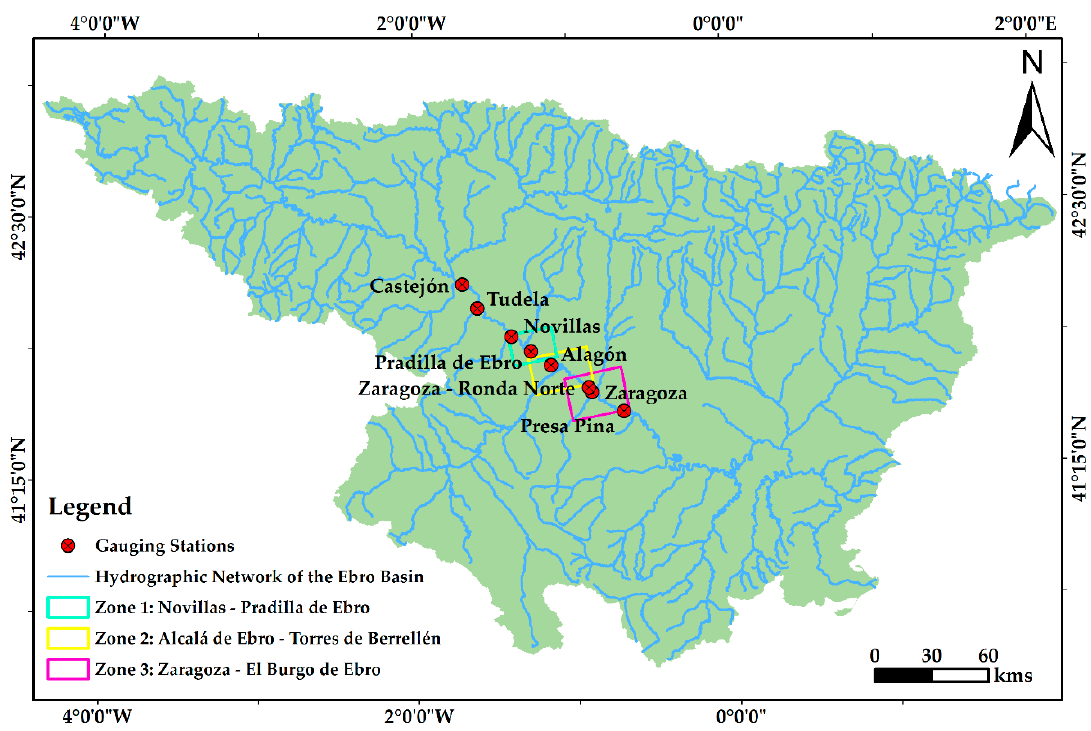
Figure 2. Location map of the gauging stations considered in the study.